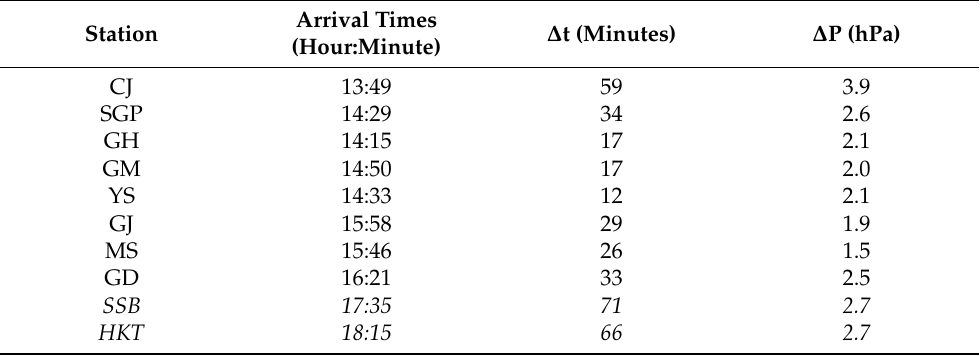
Table 1. Start time and maximum height ( ∆ P) of atmospheric pressure disturbances at the coastal stations on 7 April 2019. ∆ t is the corresponding elapsed time in the change of atmospheric pressure ( ∆ P). Intervals of atmospheric pressure data at SSB and HKT are 10 min and their station name, arrival time, ∆ t, and ∆ P are in